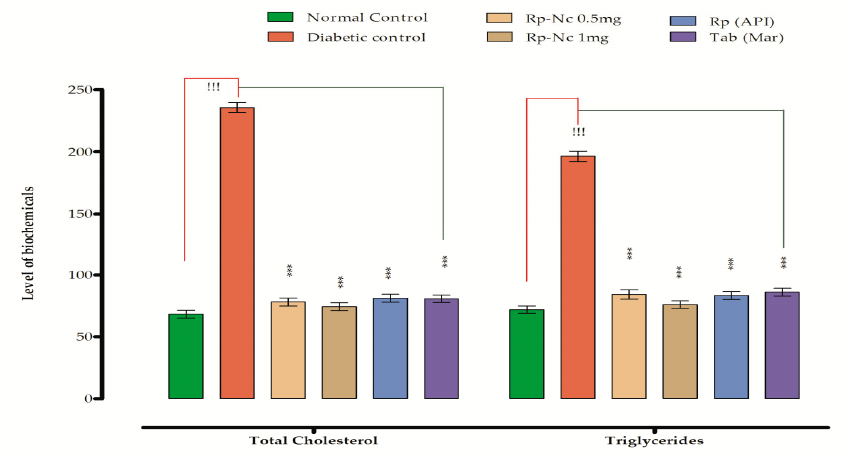
Figure 7. Effect of Rp-Nc on level of biomarkers. Mean ± SEM ( n = 8). Significance was determined statistically using one way ANOVA following Dunnett’s comparison test, !!! p < 0.001 vs. normal control group and (*** p < 0.001, n = 8) by vs. diabetic control group.